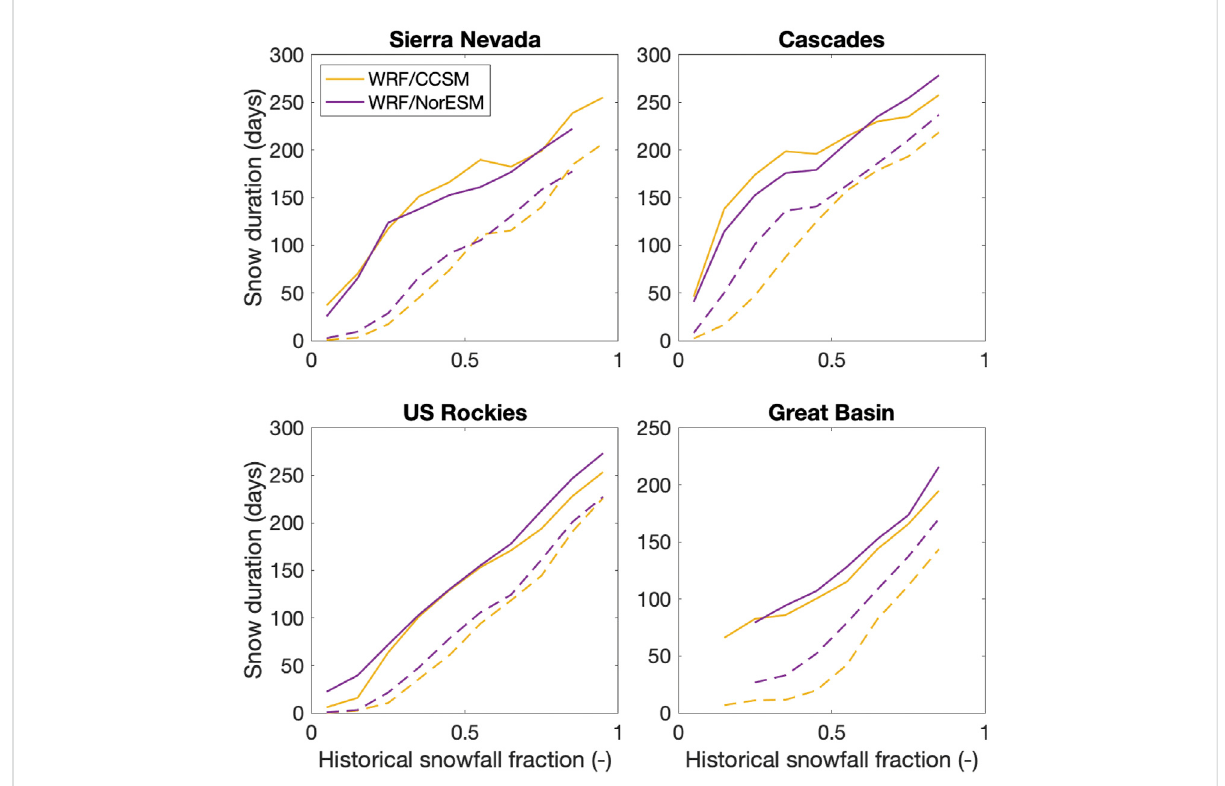
In all plots, both historical (solid lines) and end-century (dashed lines) relationships are determined with historical snowfall fraction values in order to compare over the same grid cells. Snow duration values correspond to historical and end-century values.